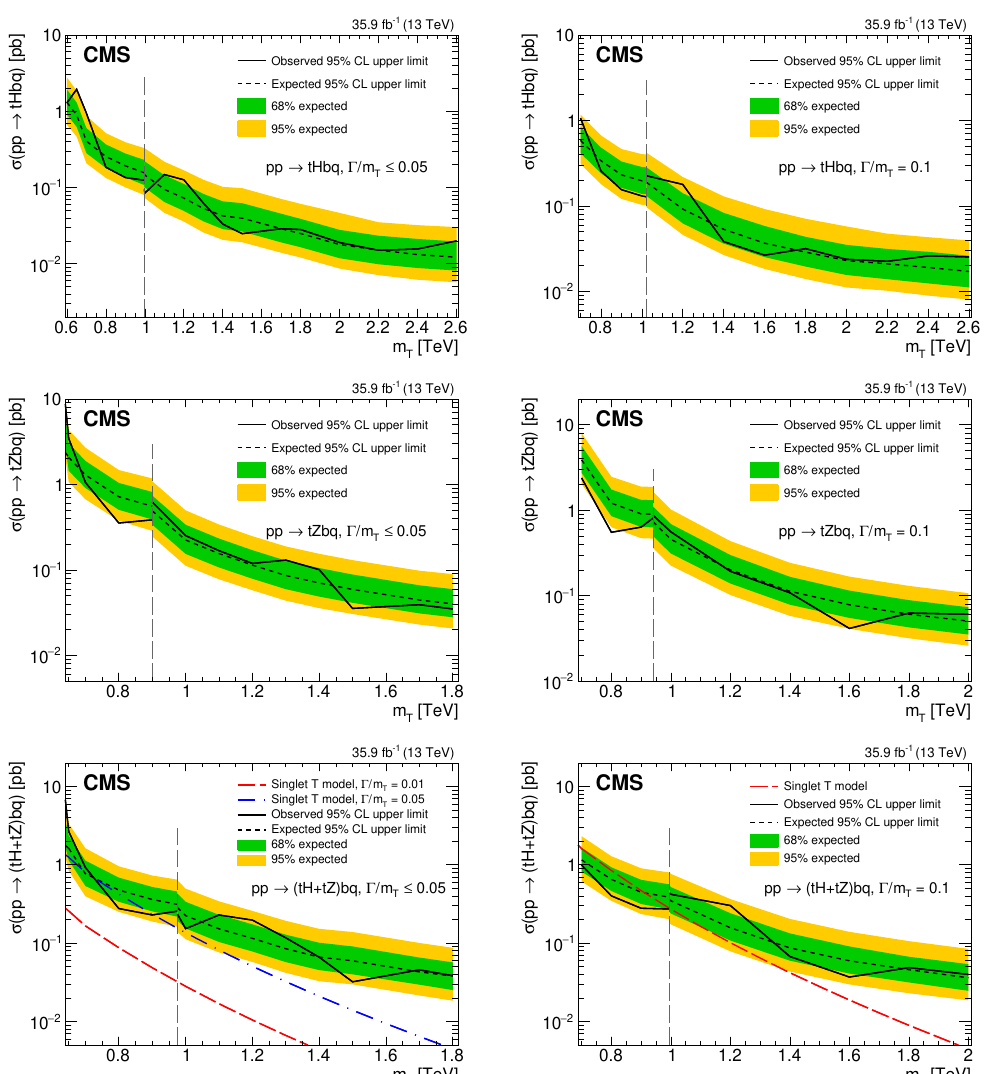
Figure 8 . The observed and median expected upper limits at 95% CL on the cross sections for production associated with a bottom quark for the tHbq (upper row) and tZbq (middle row) channels, and their sum, tHbq + tZbq (lower row), for di(cid:11)erent assumed values of the T quark mass. The inner (green) band and the outer (yellow) band indicate the regions containing 68 and 95%, respectively, of the distribution of limits expected under the background-only hypothesis. (cid:20) 0 : 05) and the right column is for a The left column is for a narrow fractional width ((cid:0) =m T fractional width of (cid:0) =m = 0 : 1. The vertical dashed lines are the crossover points in sensitivity T that indicate the mass intervals used for presenting the low-mass and high-mass search results. The dashed red and dot-dashed blue curves are for the T singlet model. Given the speci(cid:12)ed width, the couplings are implicit in the model. Two curves corresponding to (cid:0) =m = 0 : 05 (dot-dashed blue) T and (cid:0) =m = 0 : 01 (dashed red) are shown for the narrow fractional width. T